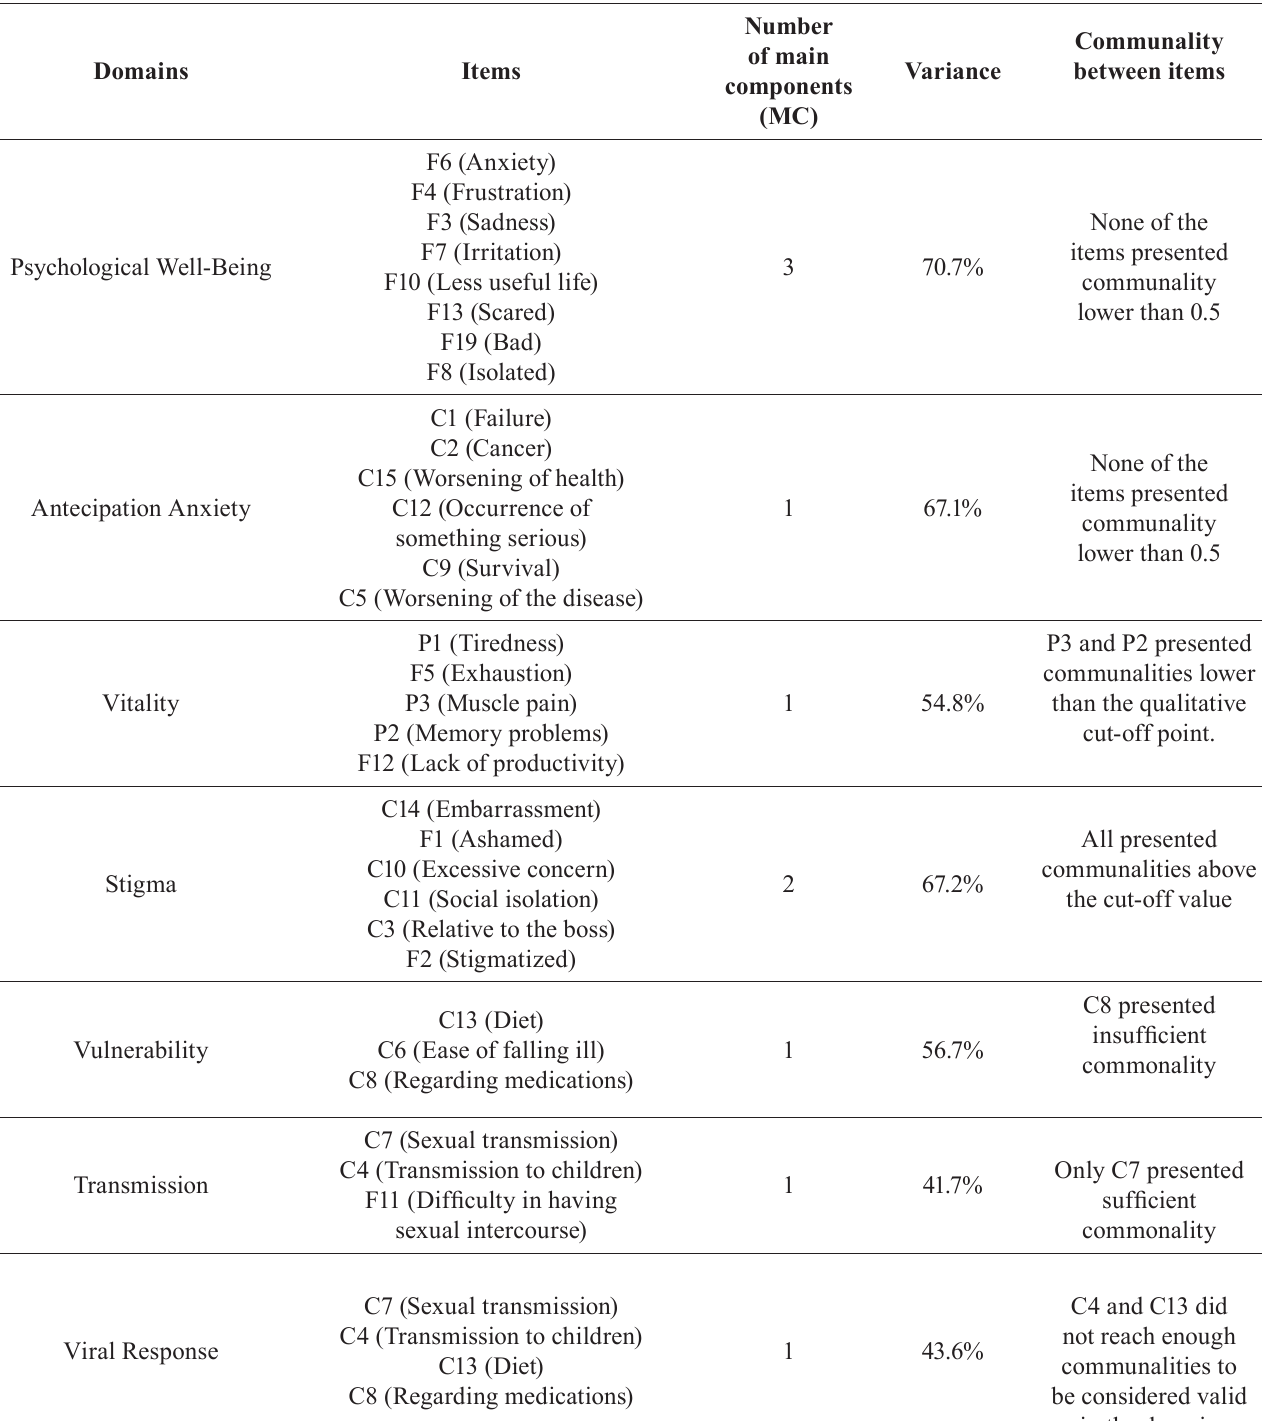
TABLE II - Factor Analysis between the items in each domain of the questionnaire